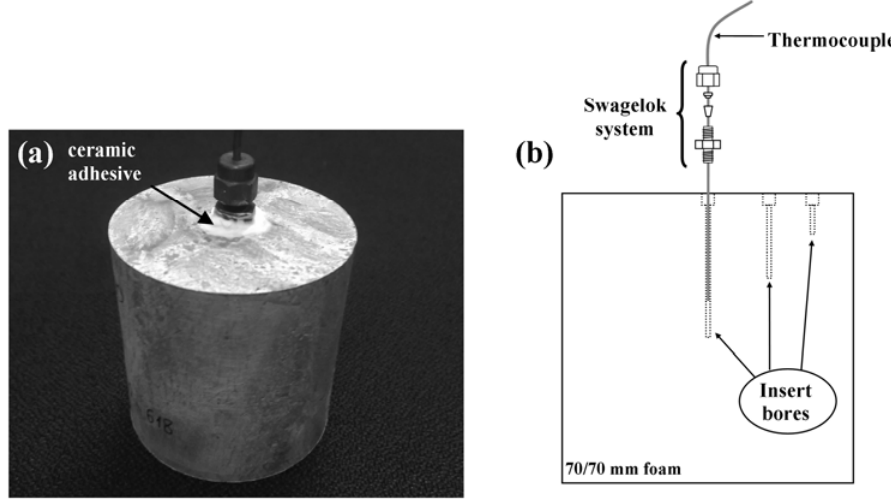
Figure 3. ( a ) Photography of the assembly mounted in a 50/50 mm foam. ( b ) Schematic draw of the 3-thermocouples assembly used in the 70/70 mm